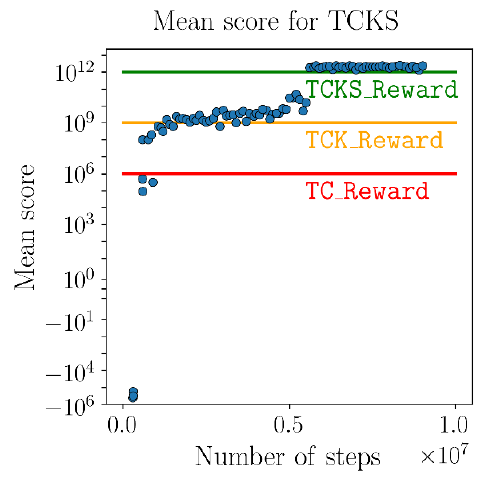
Figure 4 . Plots illustrating how the agent learns to solve multiple RL-tasks: (cid:12)rst to solve the IIA tadpole constraint, then the K-theory constraint, and (cid:12)nally the SUSY